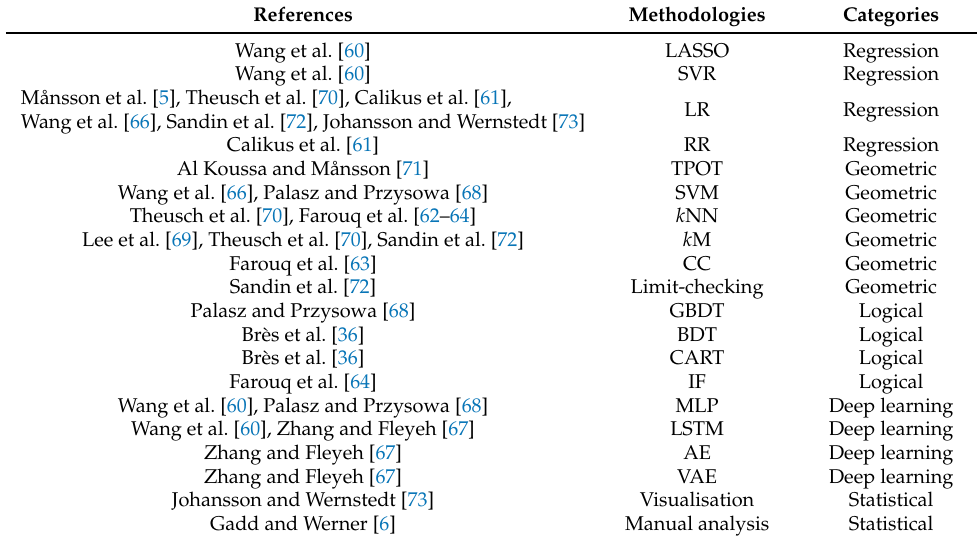
Table 4. Summary of applications of outlier detection